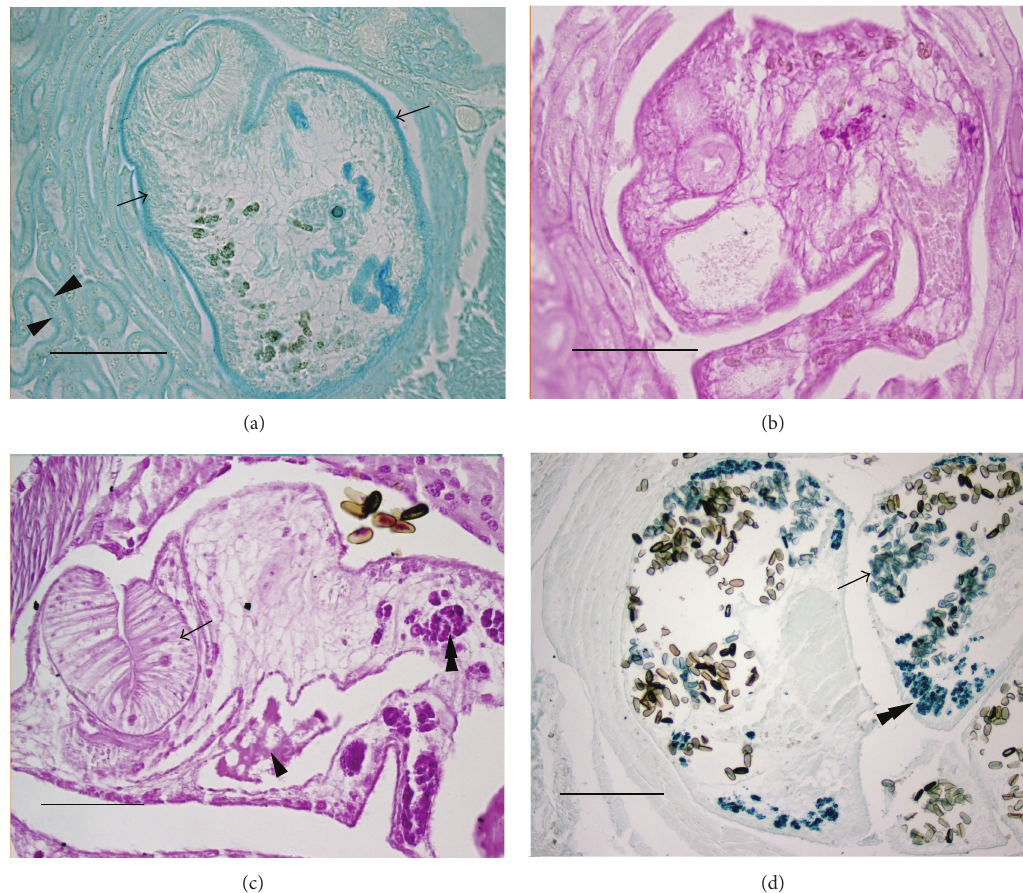
Figure 2: Histochemical staining of healthy A. renale within the host. (a) Alcian blue pH 2.5 staining for acidic mucosubstances. The tegument of the worm stains strongly (arrows) as do the apical and basal borders of the cuboidal antennal gland tubule cells (arrowheads). No metacercarial wall is present. (b) Periodic acid-Schiff staining for neutral carbohydrates reveals uniform staining of A. renale and no metacercarial wall. (c) Ninhydrin-Schiff staining for amino acids reveals light staining of A. renale parenchyma and no metacercarial wall. Arrow: oral sucker; arrowhead: intestinal contents; and double arrowhead: vitellarium. (d) Ferro-ferricyanide staining reveals tyrosine-based material within the vitellarium (double arrowhead) and egg shells (arrow) but no melanin reaction from the host tissue. (a)–(c) Bars = 100 𝜇 m. (d) Bar = 200 𝜇